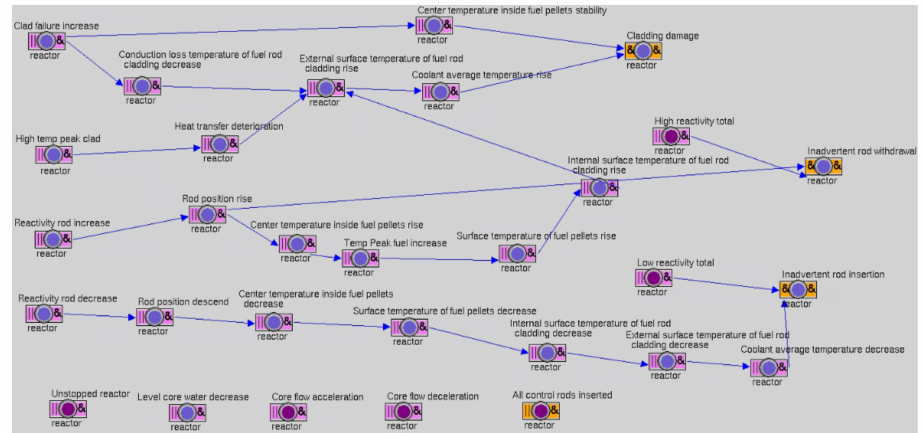
Figure 26. Design of the inference engine for the